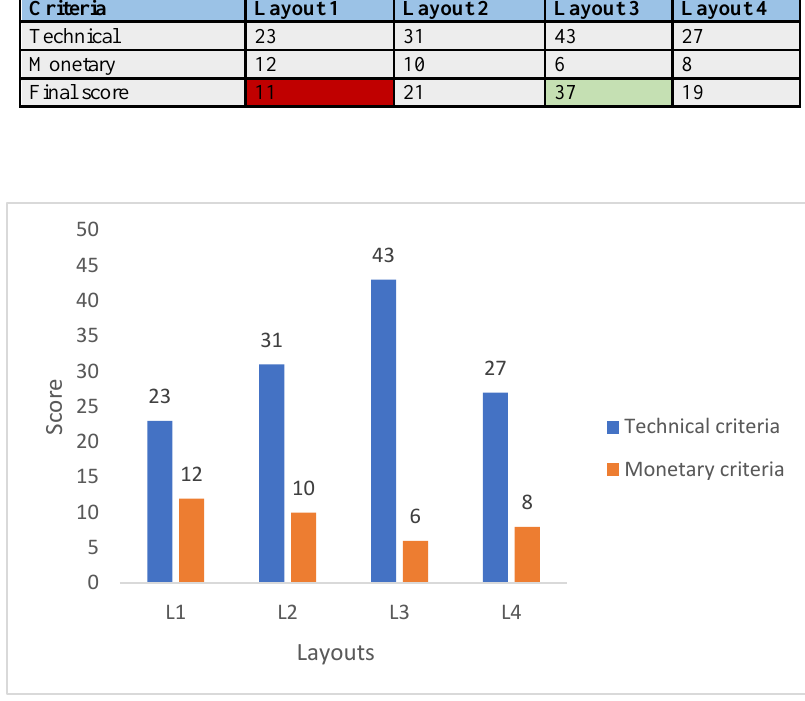
Figure 14. Comparation between the 2